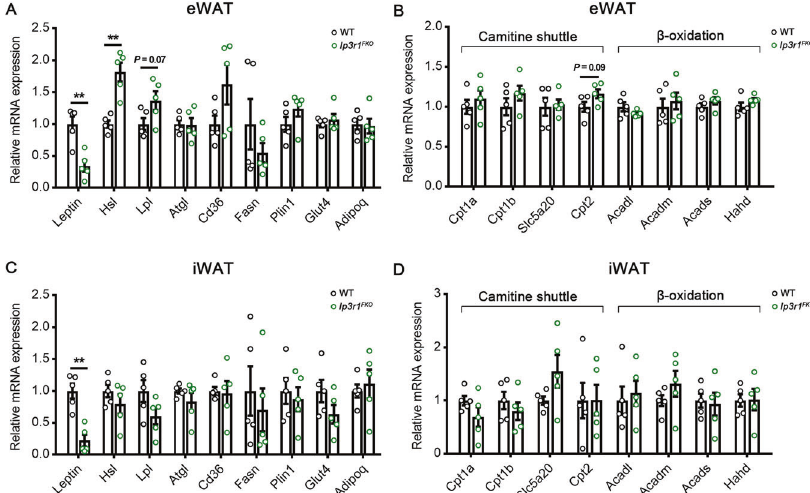
Fig. 6 Expression pro fi le of genes related to fatty acid metabolism in white adipose tissues. Relative mRNA expression levels of genes related to lipid synthesis, carnitine shuttle, and β -oxidation in ( A , B ) eWAT and ( C , D ) iWAT isolated from WT and Ip3r1 FKO mice maintained on a high-fat diet for 8 wk ( n = 5). All Data were analyzed by two-tailed unpaired Student ’ s t test and presented as means ± SEM. ** P <